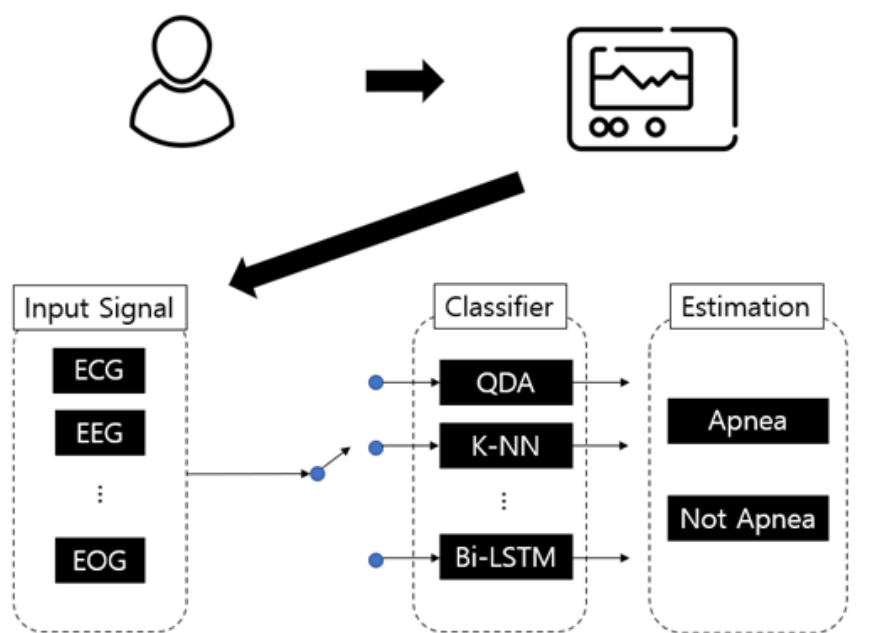
Figure 1. Flowchart of existing research in apnea